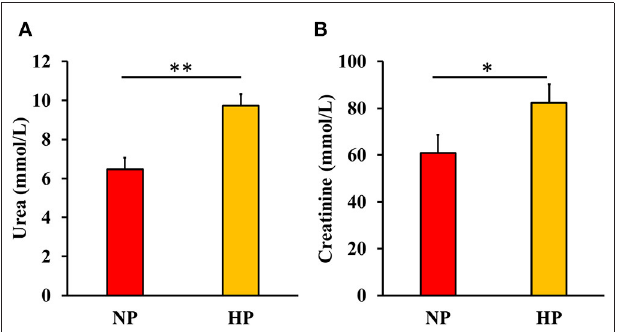
Means within a same row with no common superscript differ significantly (P < 0.05).